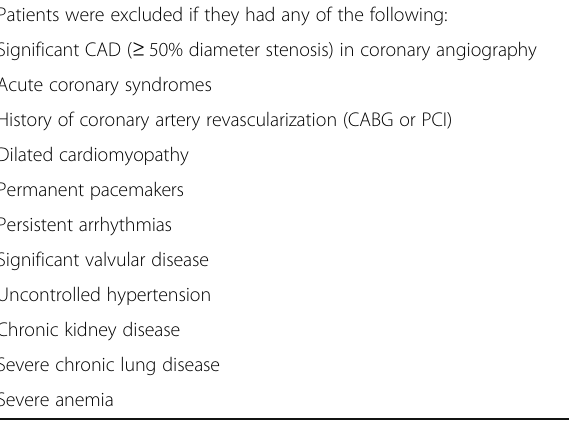
Table 1 Exclusion criteria of the study cohort Patients were excluded if they had any of the following: Significant CAD ( ≥ 50% diameter stenosis) in coronary angiography Acute coronary syndromes History of coronary artery revascularization (CABG or